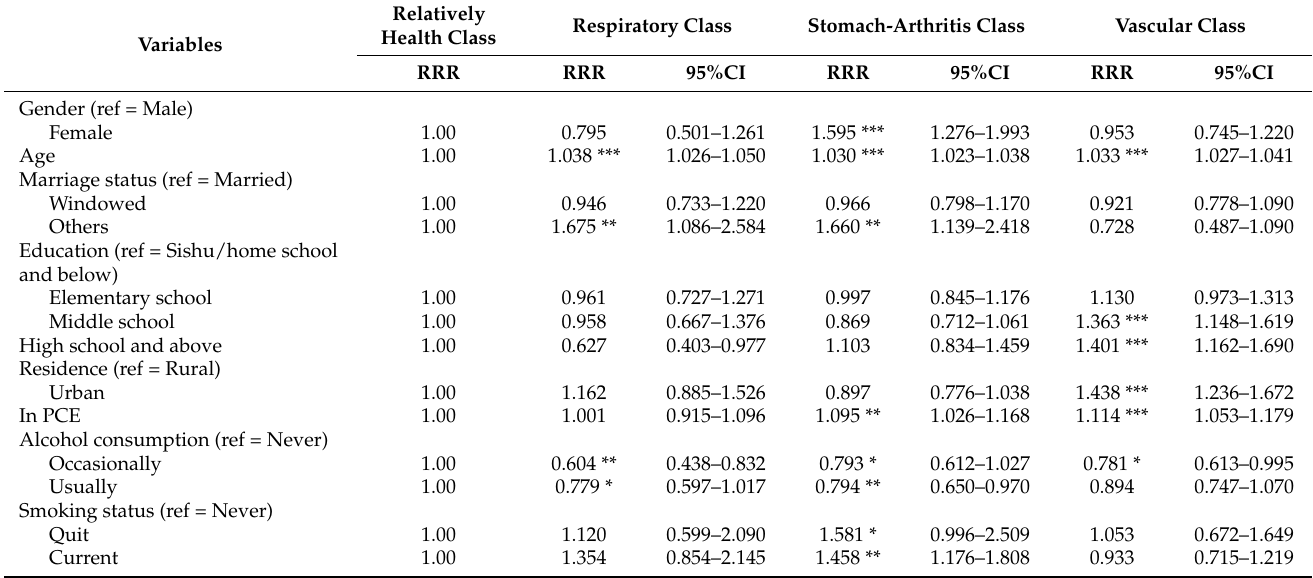
Table 2. Multinomial logit analysis of the factors associated with multimorbidity